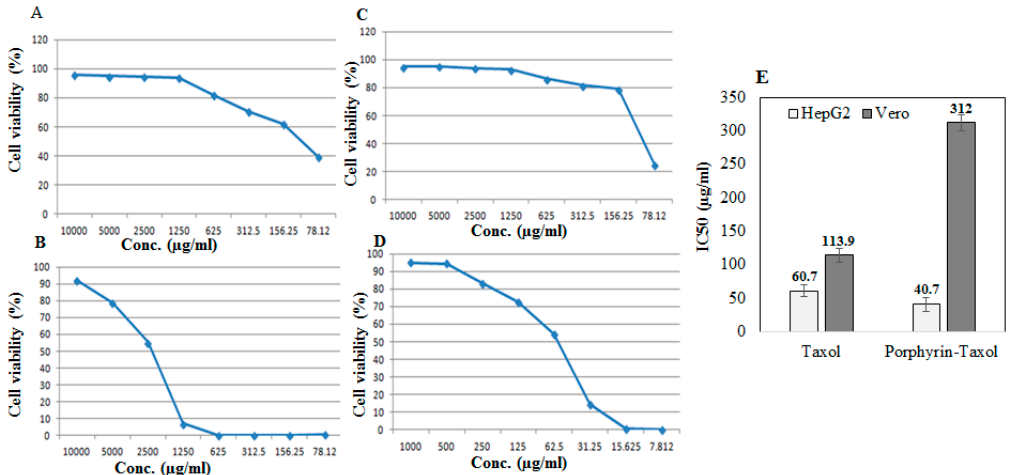
Figure 5. Antiproliferative activity of native Taxol and porphyrin–Taxol conjugates towards HepG2 and VERO normal cell lines. Antiproliferative dose–response curve of native Taxol towards VERO normal cells ( A ), HepG2 tumor cells ( B ), and Porphyrin-Taxol conjugates towards VERO normal cells ( C ) and HepG2 tumor cell lines ( D ). The IC 50 values of native and Porphyrin-Taxol conjugates towards VERO normal cells and HepG2 tumor cells ( E ).